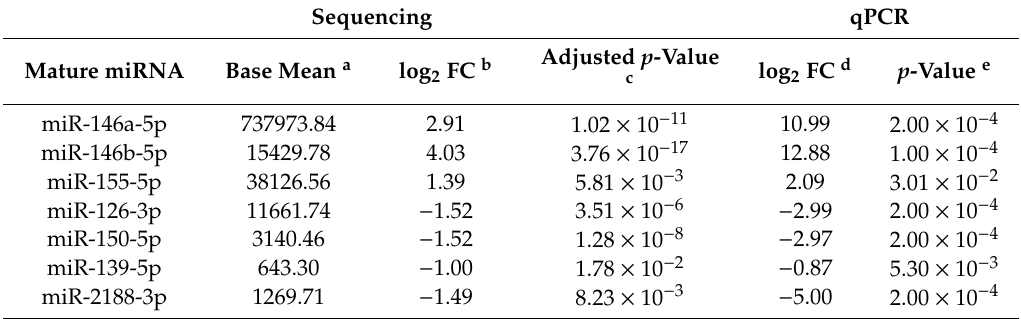
Table 3. Selected predicted miRNA targets.